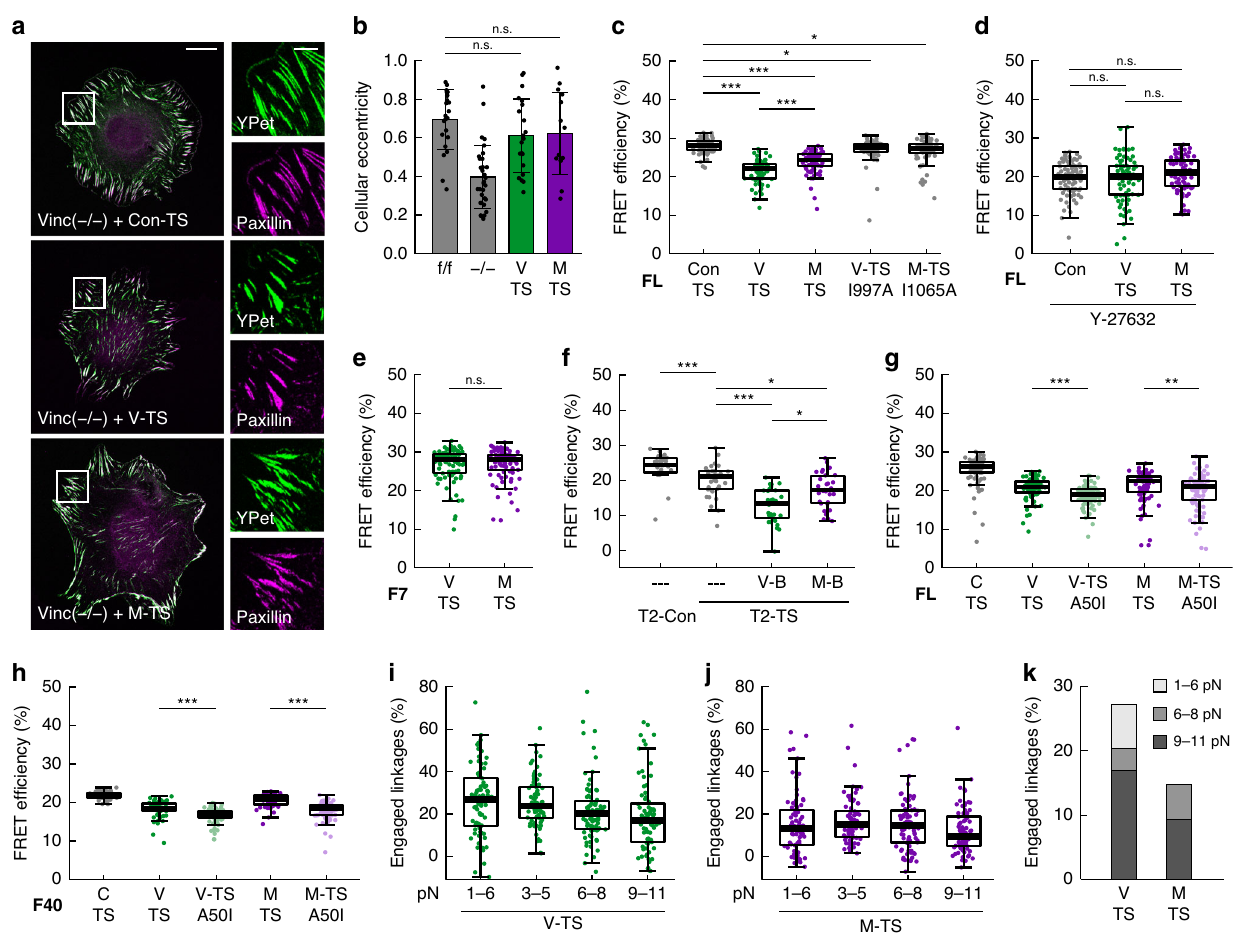
Fig. 2 Force transduction in FAs is vinculin isoform-dependent. a Representative images of vinculin-de fi cient (vinc ( − / − ) ) cells expressing vinculin tension sensor (V-TS), metavinculin tension sensor (M-TS), and the no-force control (Con-TS) 4 h after spreading on FN-coated glass coverslips show localization of all constructs to FAs (YPet), which are visualized by paxillin staining. Scale bar: 20 µ m, in zoom: 5 µ m. b Expression of V-TS or M-TS rescues the spreading defect of vinc ( − / − ) cells; data of the parental (vinc (f/f) ) and vinc ( − / − ) cells are the same as in Fig. 1b. ( n = 23, 32, 21, 14 cells). The bar chart shows the mean values ± SD. c Live-cell FLIM measurements of vinc ( − / − ) cells expressing FL-based tension sensors demonstrate FRET ef fi ciency differences between V-TS and M-TS. Impairing actin binding by inserting the I997A mutation into vinculin (V-TS-I997A) and I1065A into metavinculin (M- TS-I1065A) strongly reduces tension and eliminates vinculin isoform-speci fi c differences. ( n = 73, 73, 74, 72, 73 cells). d Live-cell FLIM measurements of FL-based Con-TS, V-TS, and M-TS expressed in talin-de fi cient cells (tln1 − / − tln2 − / − ), seeded on pLL-coated dishes and treated with Y-27632, con fi rmed that FRET differences are force-speci fi c. ( n = 80, 80, 82 cells). e Highly similar FRET ef fi ciencies of force-insensitive vinculin (V-F7-TS) and metavinculin (M-F7-TS) tension sensor controls expressed in vinc ( − / − ) cells demonstrate that vinculin isoform-speci fi c effects are conformation-independent ( n = 86, 85 cells). f Talin-2 tension sensor (T2-TS) measurements in vinc ( − / − ) cells expressing TagBFP-tagged vinculin (V-B) and metavinculin (M-B) show that vinculin isoform-speci fi c force transduction propagates across talin-2. T2-Con: talin-2 no-force control. ( n = 30, 36, 31, 31 cells). g , h The A50I point mutation, which reduces the binding af fi nity of (meta)vinculin to talin, caused a FRET ef fi ciency decrease in FL- and F40-based vinculin (V-TS-A50I) and metavinculin (M-TS-A50I) samples. ( g : n = 84, 83, 78, 85, 86 cells; h : n = 60, 59, 77, 57, 78 cells). i Examination of stretched sensor molecules in V-TS- expressing cells, using four different TS modules, shows that vinculin is exposed to a wide range of forces; in average, 20 – 30% of molecules experience mechanical tension ( n = 77, 73, 81, 77 cells). j Analogous analysis of M-TS-expressing cells indicates that the fraction of mechanically engaged metavinculin molecules is <20%. Note the equal amounts of stretched molecules in samples containing sensors sensitive to 1 – 6 pN, 3 – 5 pN, and 6 – 8 pN indicating comparably high force per molecule across metavinculin. ( n = 80, 74, 80, 77 cells). k Analyzing the differences of medians shown in ( i ) and ( j ) indicates that cells expressing M-TS instead of V-TS have less mechanically-engaged linkages that experience higher tension per molecule. Boxplots show median, 25th and 75th percentile with whiskers reaching to the last data point within 1.5× interquartile range. Two-sided Kolmogorov – Smirnov